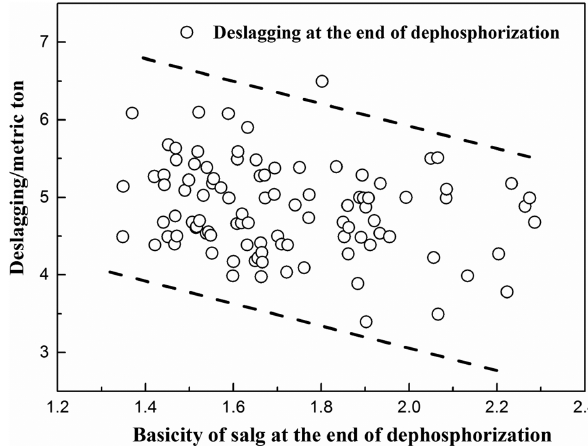
Figure 9: Relationship between deslagging amount and slag basicity at the end of